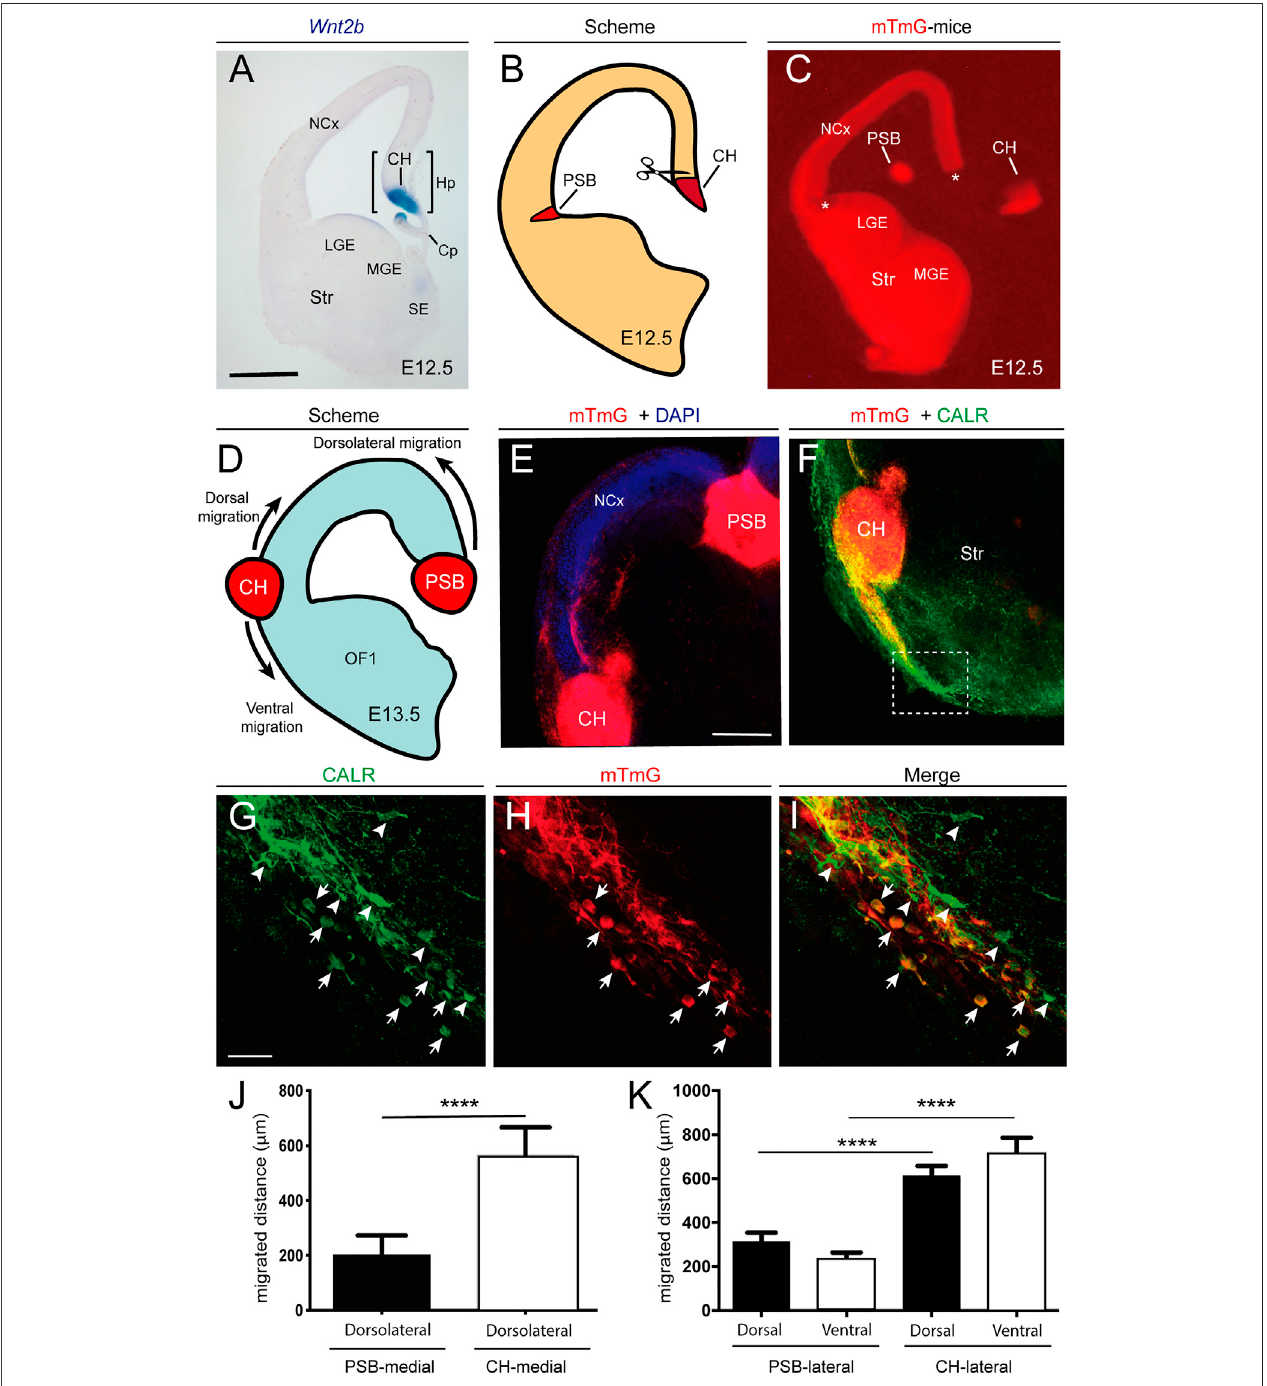
FIGURE 4 | Examples of the differential behavior of CH- and PSB-derived CR cells after transplantation experiments in telencephalic slices (A) Example of an E12.5 coronal section showing the location of the CH after Wnt2b in situ hybridization (B,C) Scheme (B) and low-power fl uorescence photomicrographs (C) illustrating the microdissectionprocedurefortheCHandthePSBusingthereportermTmGmice (D,E) Scheme (D) andconfocalmicrocopyphotomicrographs (E) illustratingthelocationof thetransplantedCHandPSBintelencephalicslices (F) PhotomicrographsillustratingthemigratorystreamofCH-derivedCRcellsaftertheirlateraltransplantation.The dashedlabelledboxisdepictedinpanelsG-I (G,I) Representativeimagesofdouble-labelledCRcells identi fi edwithCALRantibodies(left)andmTmG(center), togetherwith the resulting combined image (right). White arrows mark cells that are both CALR- and mTmG-positive,while arrowheads point to CALR-positive cells. The panelshighlight thelargenumberofdouble-labelledcellsthatmigrateventrallytothetransplantedCH,thatcontrastswiththefewerCALR-positivecells (J) Barplotsofthemigrationdistance of double-labelled (CALR-mTmG) CR cells in transplantation experiments, comparing the extent of migration of PSB and CH-derived cells transplanted in the natural CH